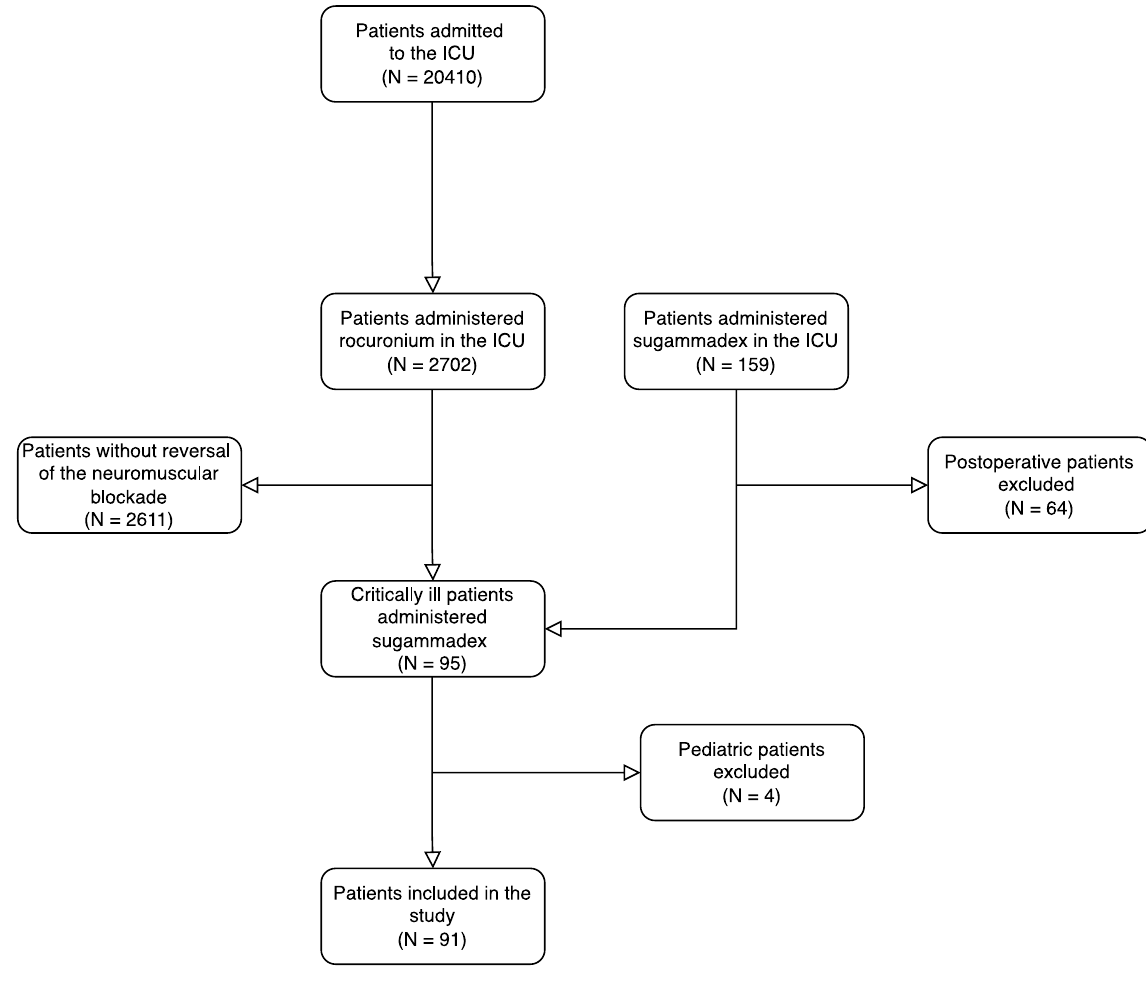
Figure 1. Summary of patient flow diagram. Diagram created using draw.io (Version 15.3.0), JGraph Ltd, Northampton, UK. URL: https:// diagr ams.